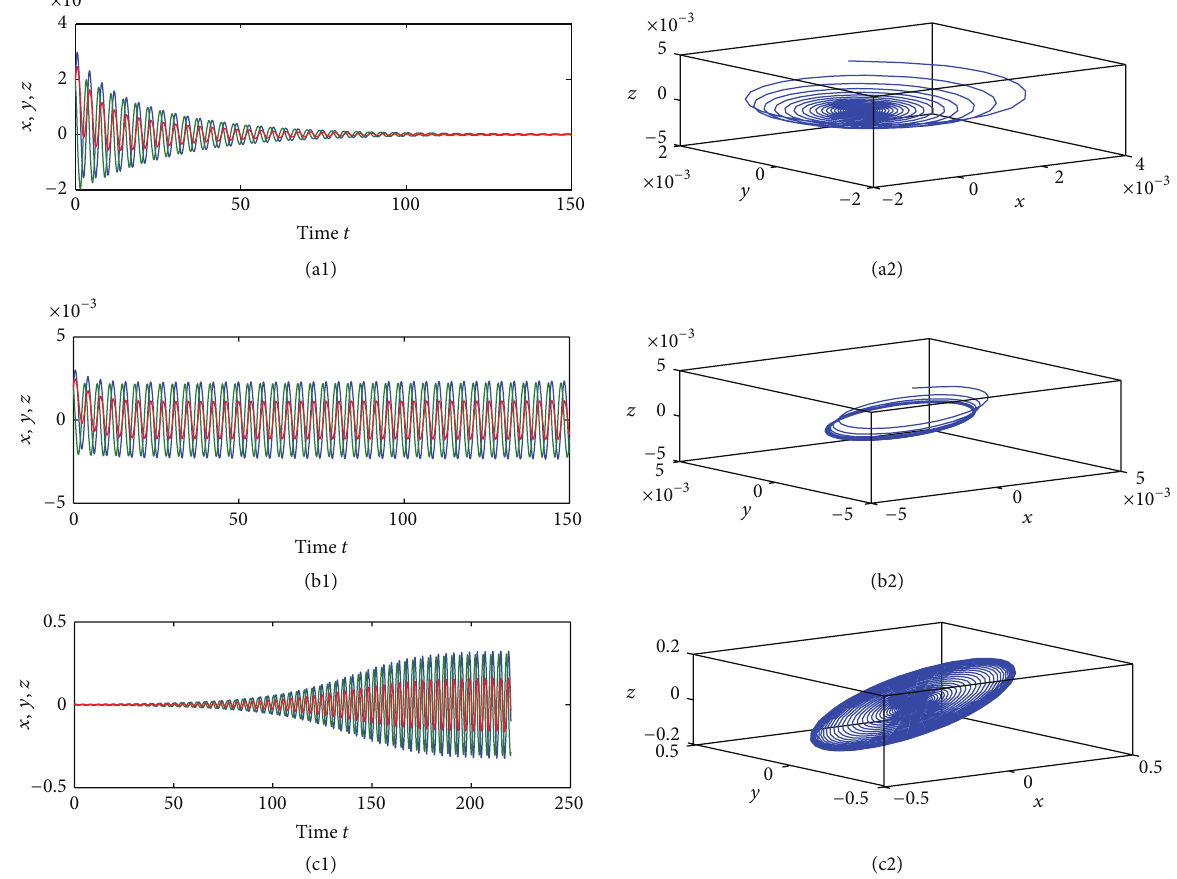
Figure 3: Time histories (a1, b1, and c1) and phase trajectories (a2, b2, and c2) of system (3) before, during, and after Andronov-Hopf bifurcation. In (a1) and (a2), 𝜏 = 0.193814883934925 < 0.213814883934925 = 𝜏 ∗ , and then the origin is locally asymptotically stable. In (b1) and (b2), 𝜏 = 0.213814883934925 = 𝜏 ∗ , and then there exists a periodic solution near the origin. In (c1) and (c2), 𝜏 = 0.233814883934925 > 0.213814883934925 = 𝜏